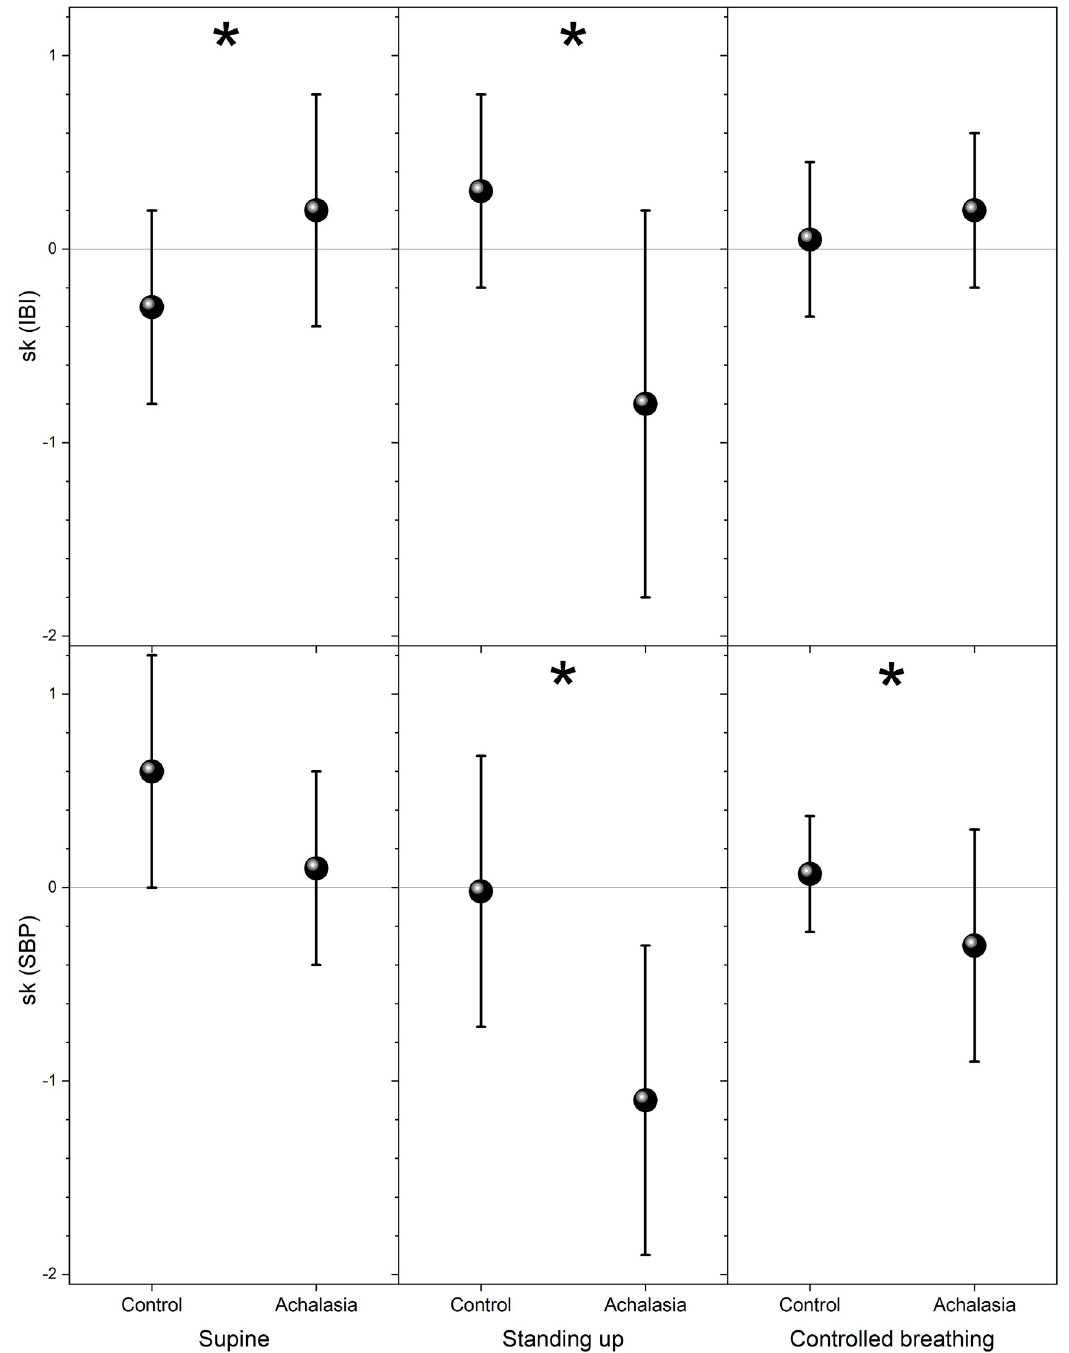
Fig 5. Skewness with respect to the median for control and achalasia groups during supine position (left-hand panels), standing up (middle panels), and controlled breathing (right-hand panels), IBI (top row), and SBP (bottom row). The vertical crosshair corresponds to one standard deviation around the population average, while the dot is the median; � indicates statistically significant difference with respect to control ( p value < 0.05).